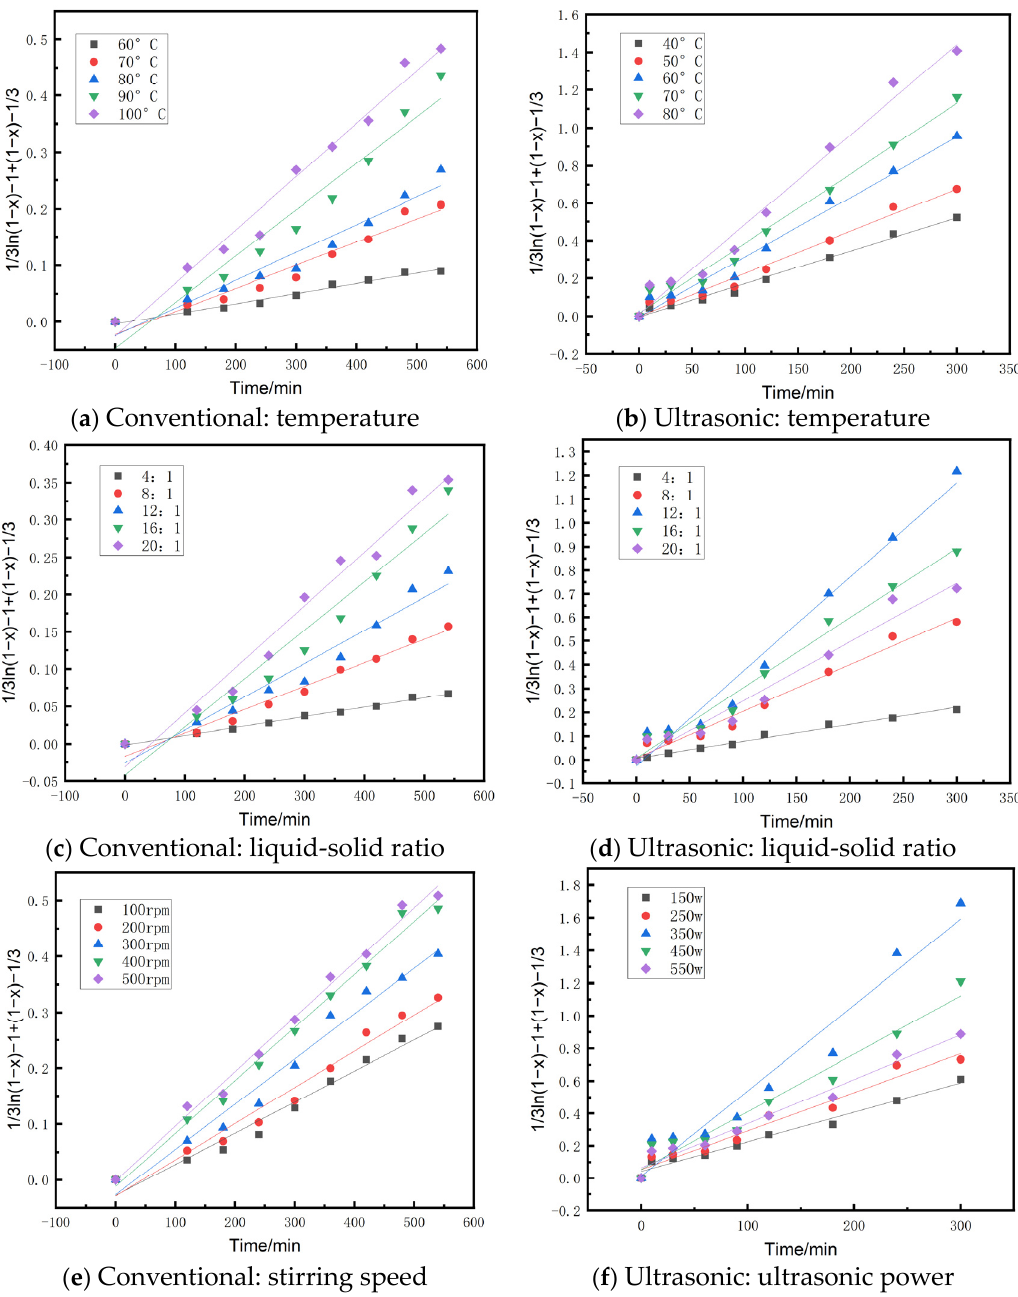
Figure 12. Fitting results of the “hybrid control model” at various leaching conditions